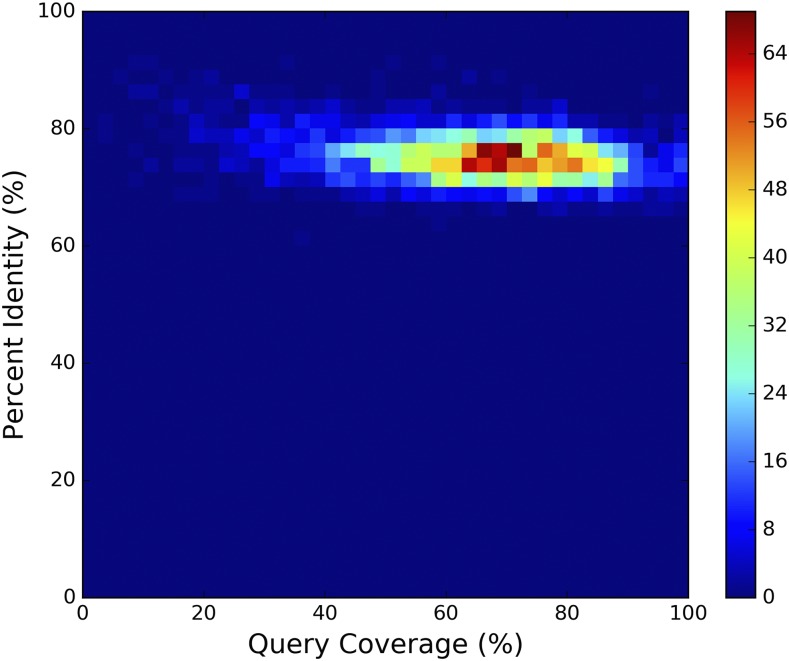
Pairwise BLASTn alignments between D. melanogaster enhancers and D. lacteicornis orthologs show highly similar sequences. 3,457 experimentally verified D. melanogaster enhancers from Kvon et al. (2014) were remapped onto the D. lacteicornis assembly using liftOver (Hinrichs et al. 2006). This yielded 3,375 reciprocal best hits between the D. melanogaster and D. lacteicornis genomes. D. lacteicornis was chosen for illustrative purposes because the assembly is close to the median scaffold NG50. The 2D histogram shows query coverage and percent identity for 3,375 pairwise D. melanogaster - D. lacteicornis BLASTn (Camacho et al. 2009) alignments. Query coverage is the percentage of D. melanogaster sequence that aligned to D. lacteicornis sequence; and percent identity is the length-weighted percent identity for hits in the alignment.